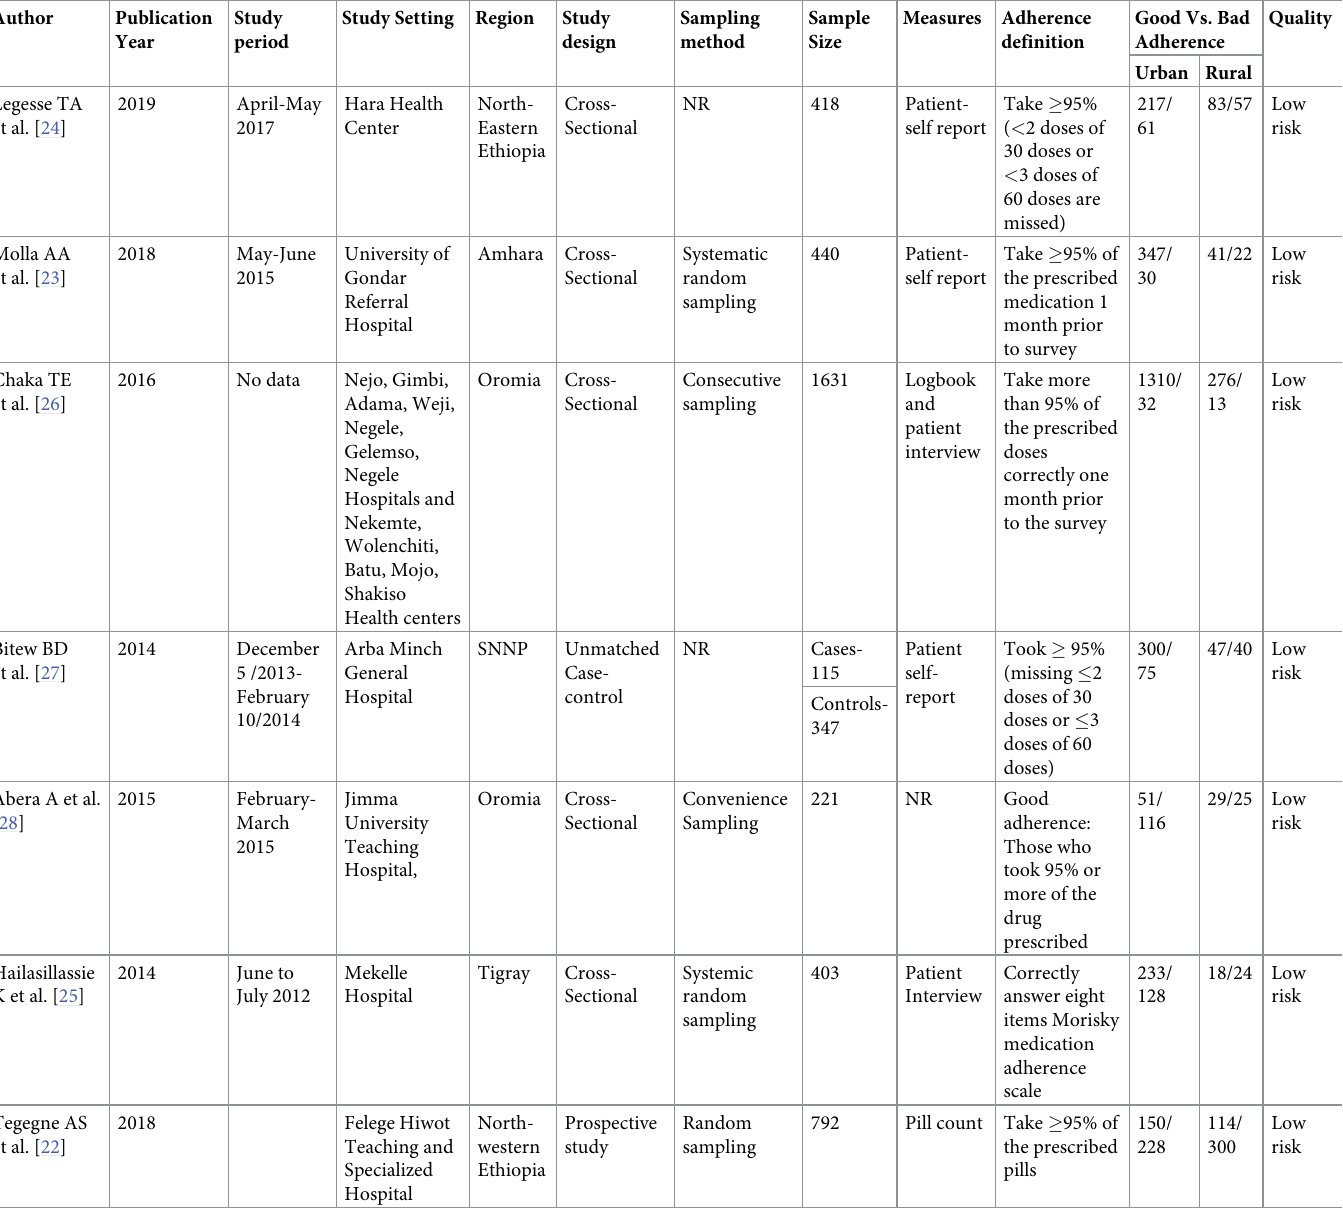
Table 1. Characteristics of the study involved in the systematic review and